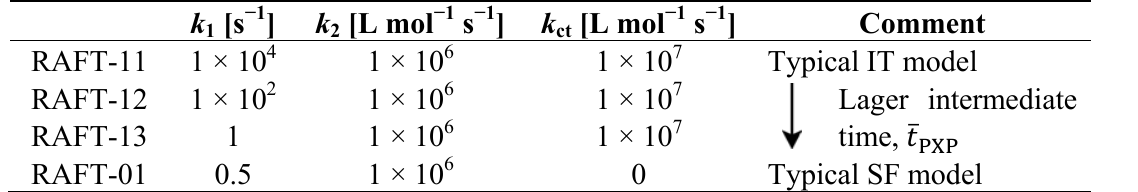
= 1 × 10 − 7 mol L − 1 s − 1 , I